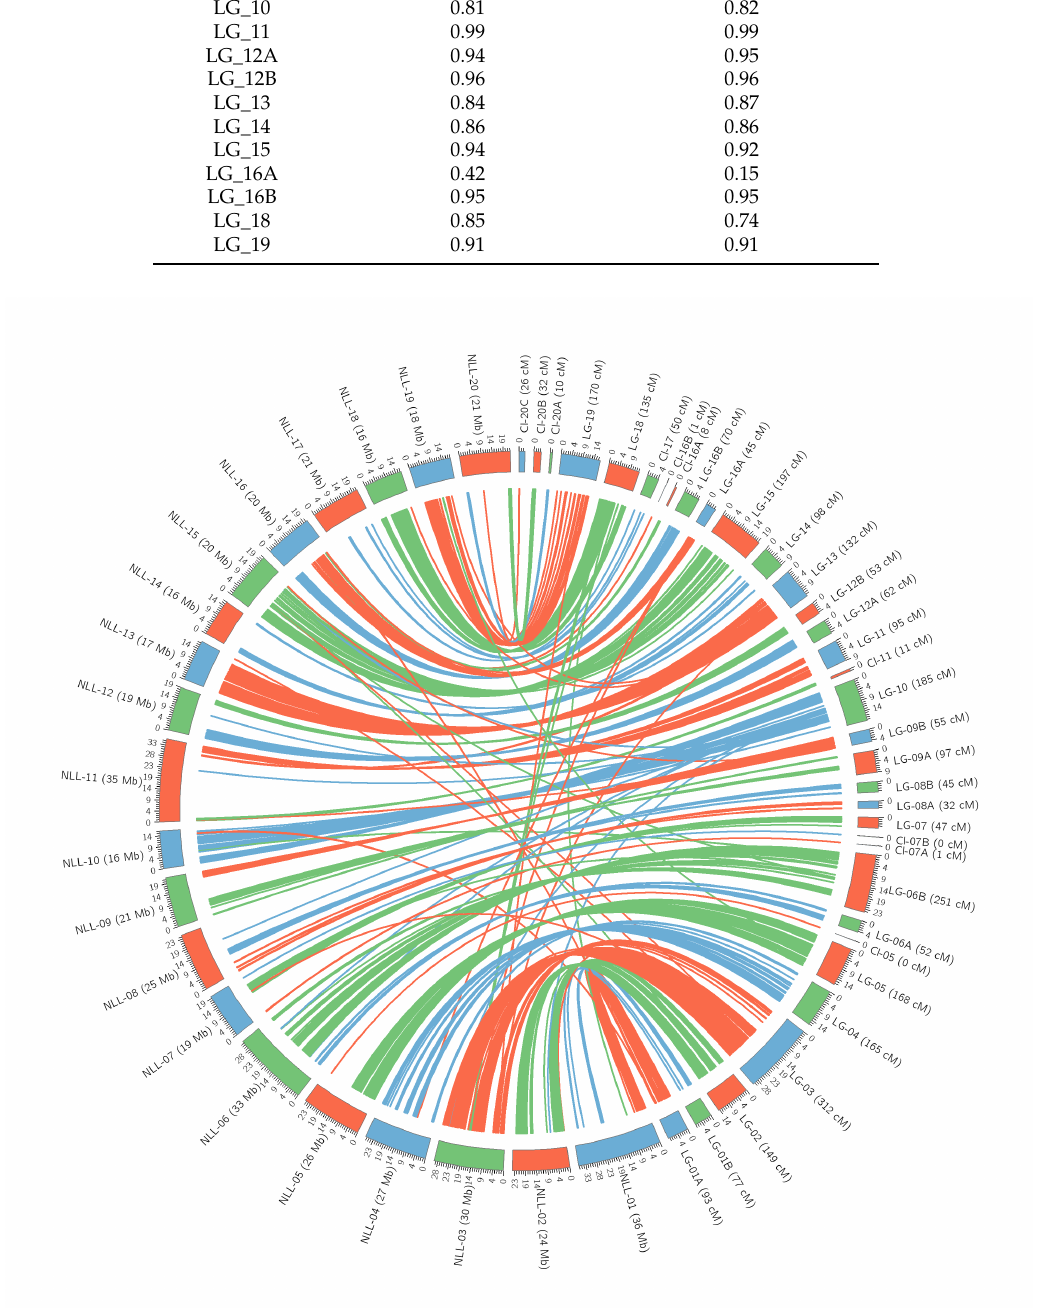
Figure 4. Circos plot, comparing obtained genetic linkage maps to Lupinus angustifolius reference genome